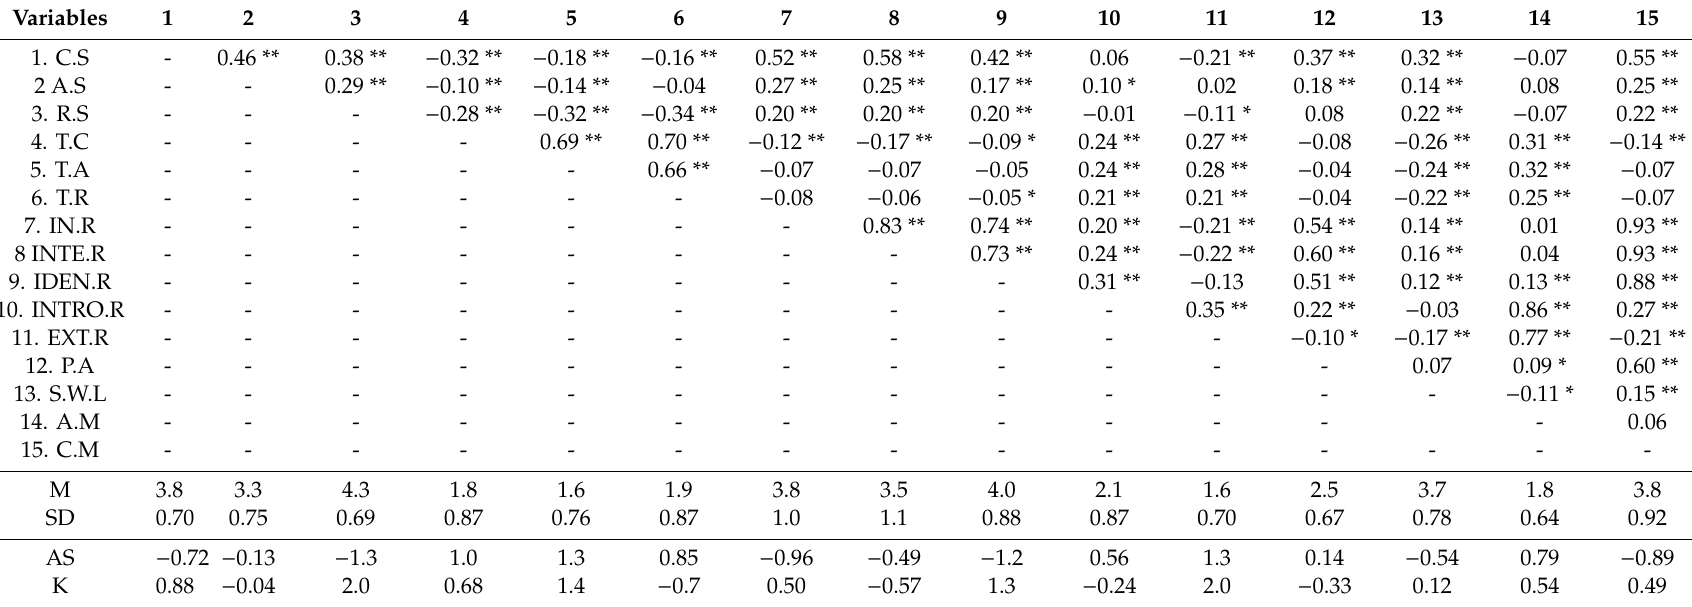
Table 2. Descriptive analysis and bivariate correlations of the